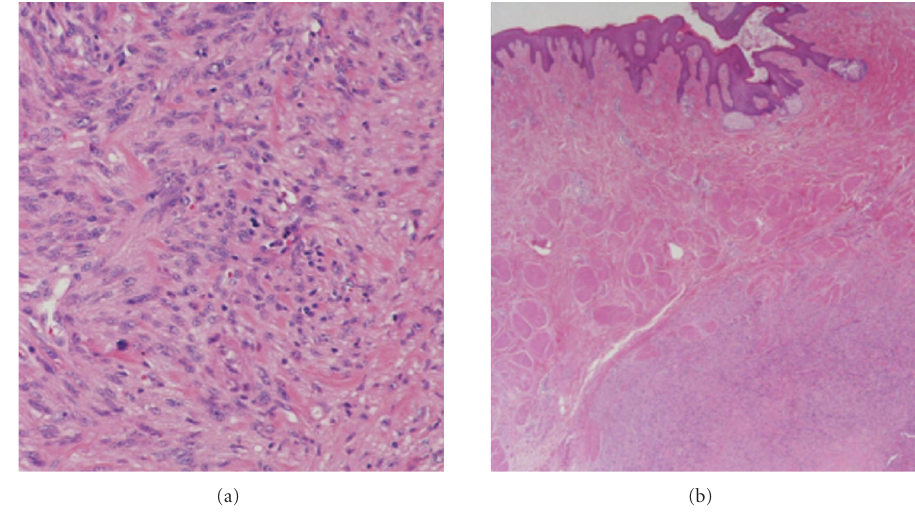
Figure 2: Histopathology section showing a spindle cell tumour with pleomorphism and mitoses. The figure on the right-hand side demonstrates also tumour cells with mitoses and paranuclear